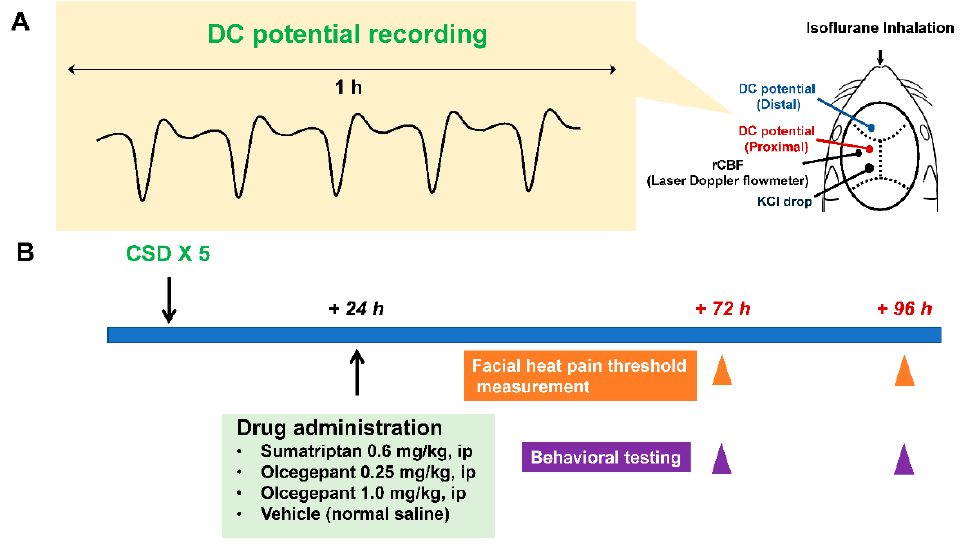
Figure 1. Schematic representation depicting experimental design and CSD induction. As shown in the upper left figure, CSD was induced five times within one hour ( A ). The experimental timeline of CSD induction, facial heat pain threshold temperature measurement, and behavioral testing in the present study is illustrated ( B ).